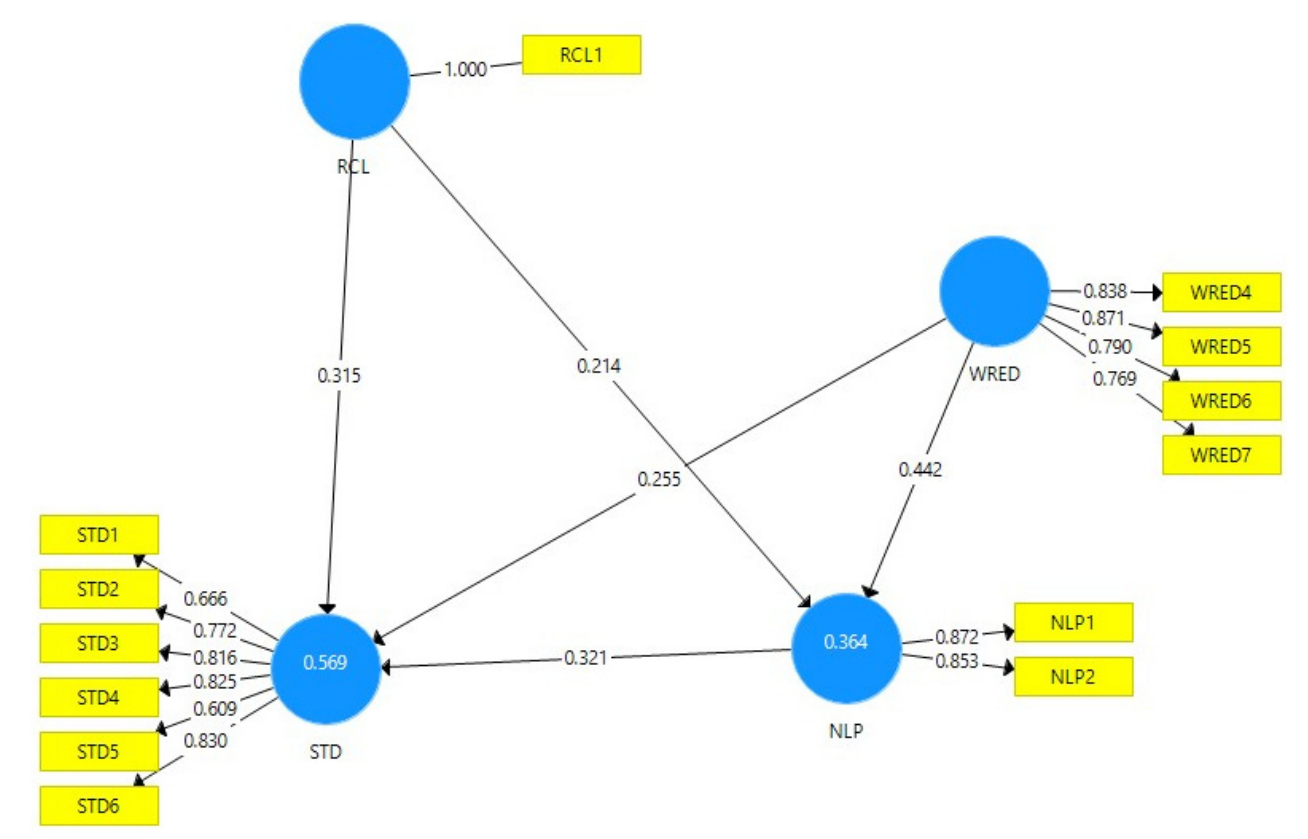
Figure 2. The path coefficients and outer loadings. PLS algorithm calculation. Source: calculated with SmartPLS. Table 3. Construct reliability and validity.